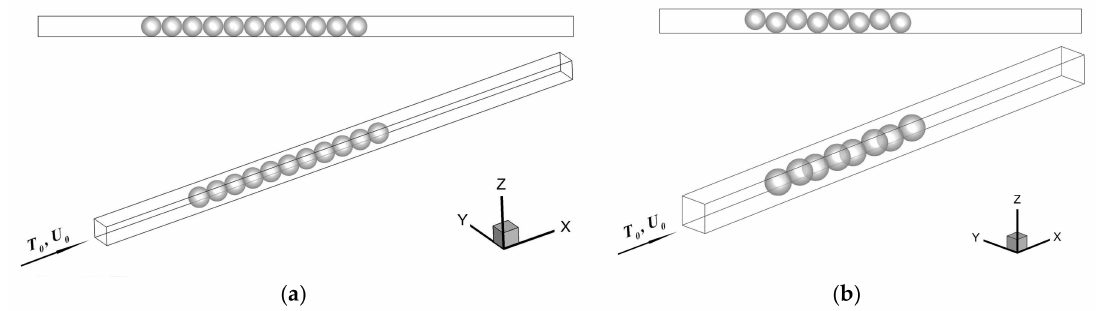
Figure 2. Schematic of wall bounded structured packed beds for ( a ) N = 1.00; and ( b ) N =